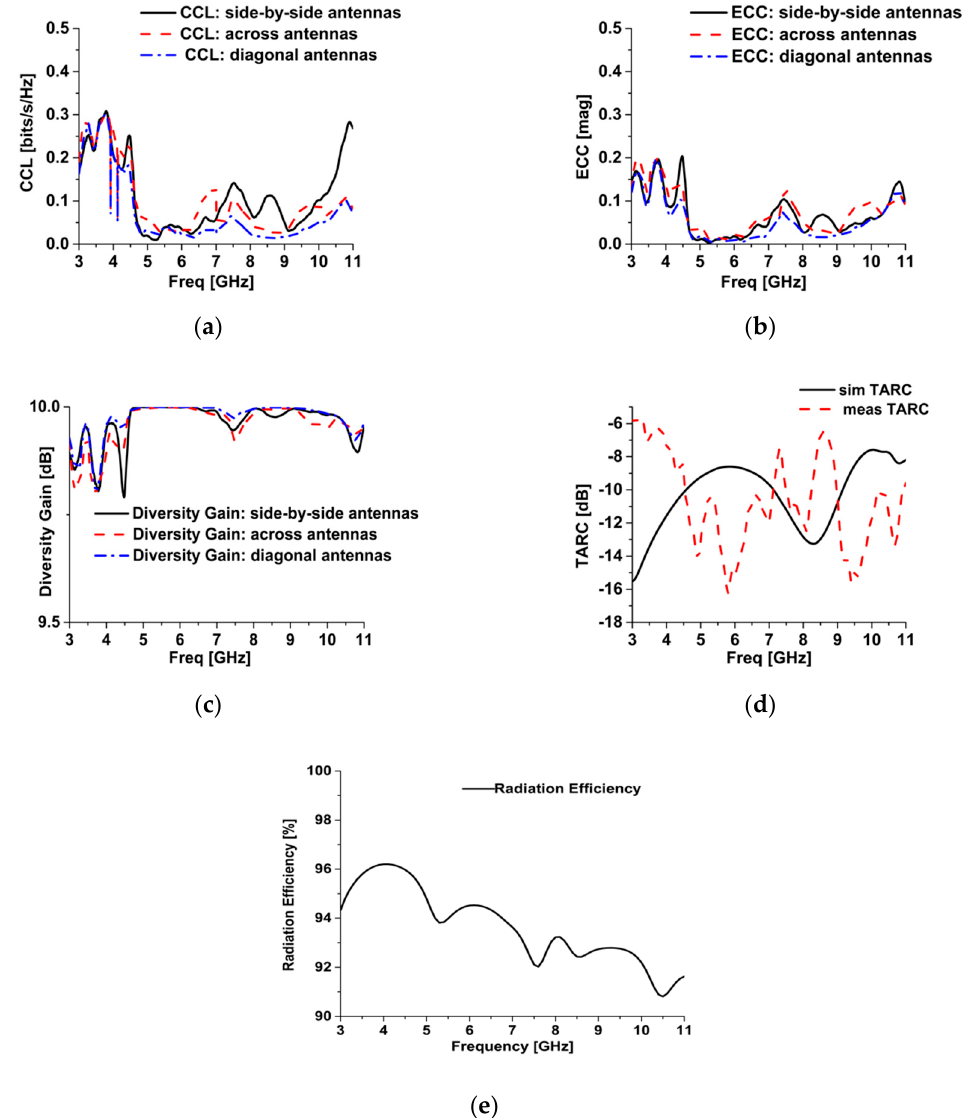
ffi ciency. Appl. Sci. 2019 , 9 , x